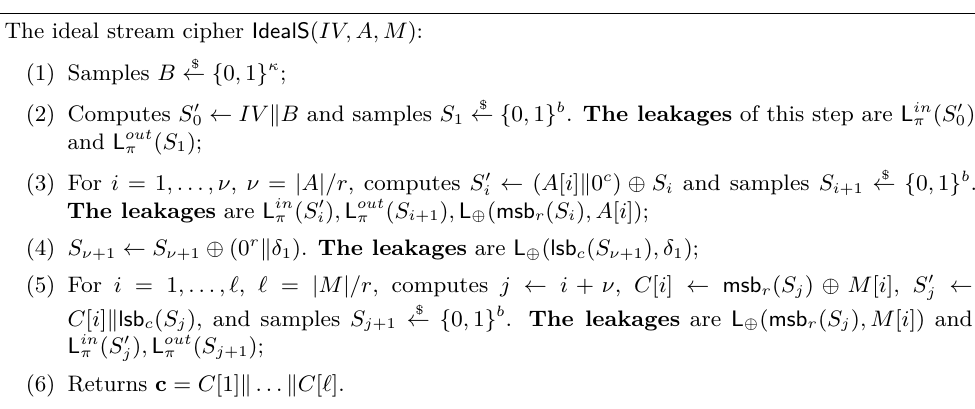
Figure 4: The ideal stream cipher IdealS and the involved